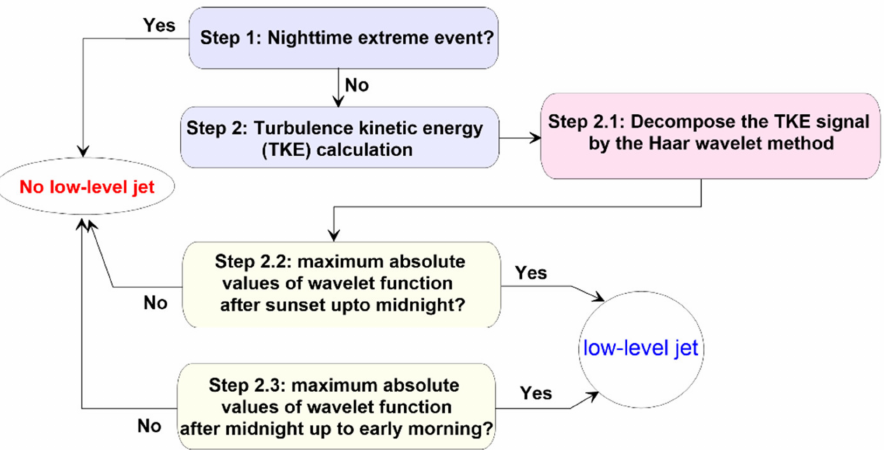
Figure 4. Flow chart for the low-level jet identification method using the Haar wavelet func- tion